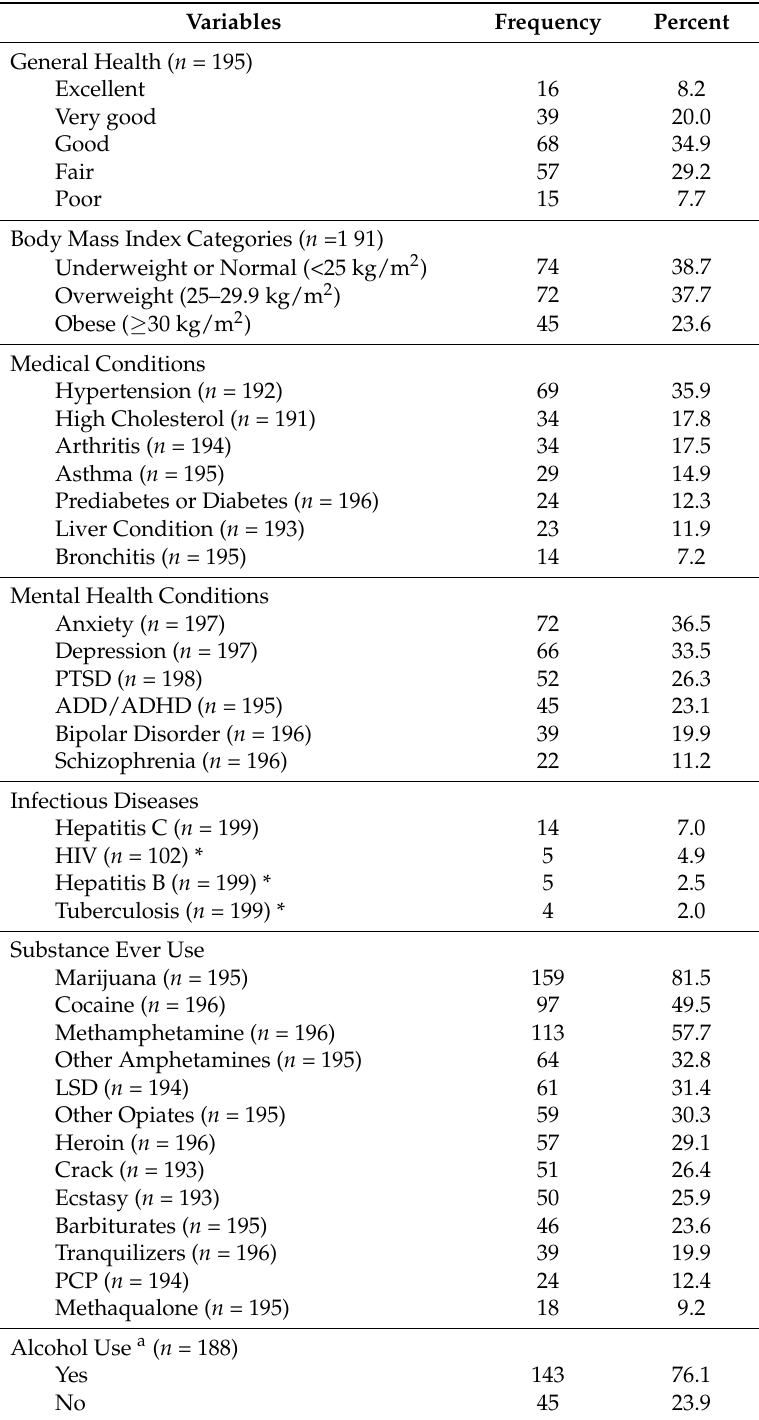
Table 3. Descriptive Statistics of Self-Reported